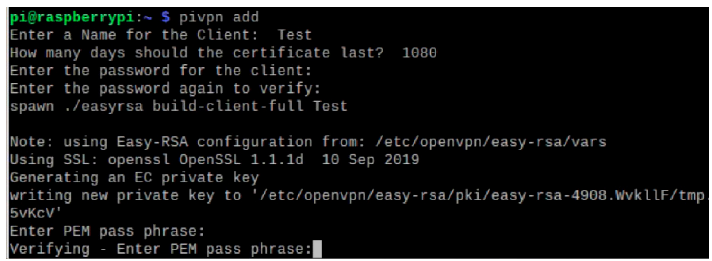
Figure 5. Illustration of OVPN script running the RSA configuration. Technologies 2020 , 8 , x FOR PEER REVIEW